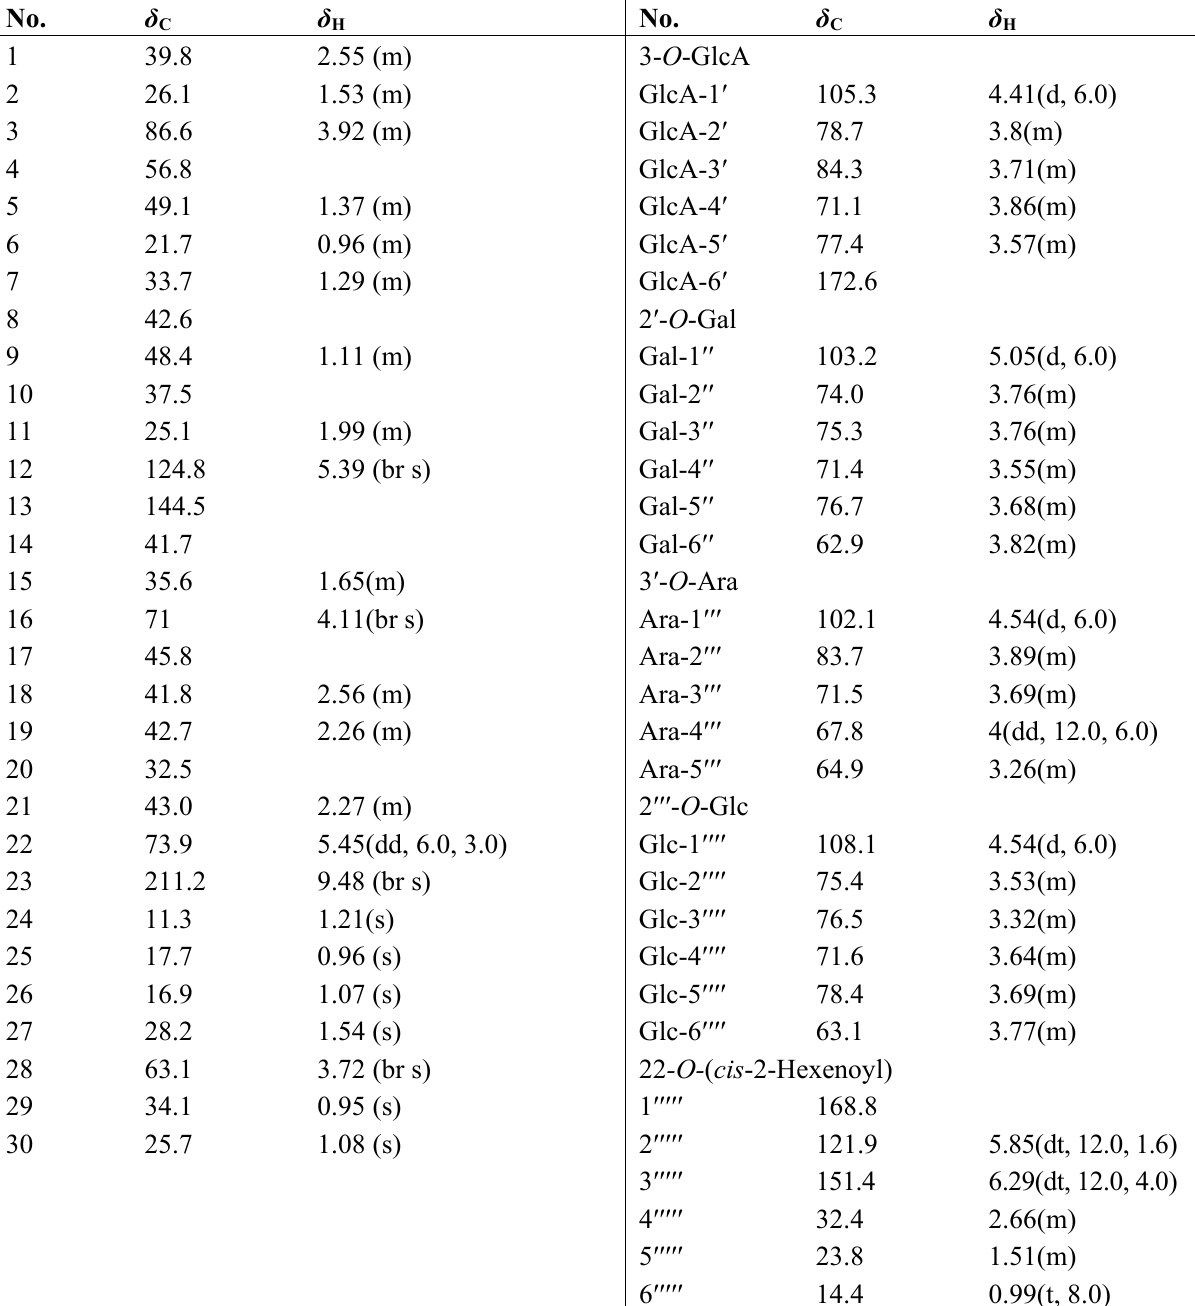
Table 1. 1 H- (400MHz) and 13 C-NMR (100MHz) data of oleiferasaponin A d ; δ in ppm, J in 4